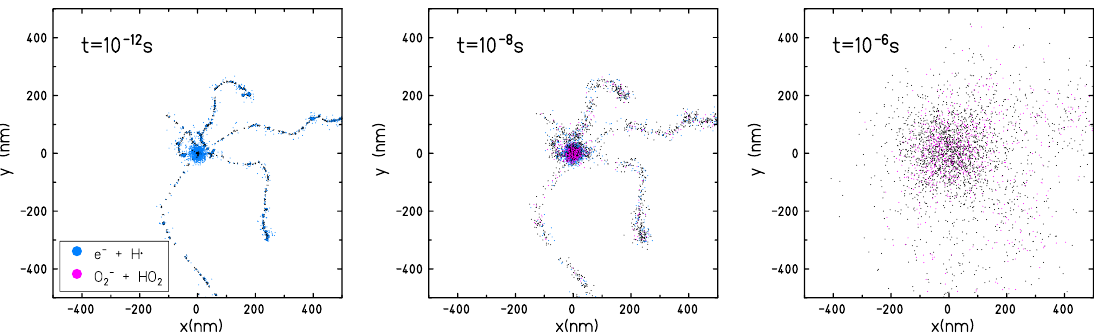
Figure 7. Chemical evolution of a 10 MeV/u carbon ion track in an oxygenated water target with an oxygen partial pressure pO 2 = 21%. Track shown in beam eye